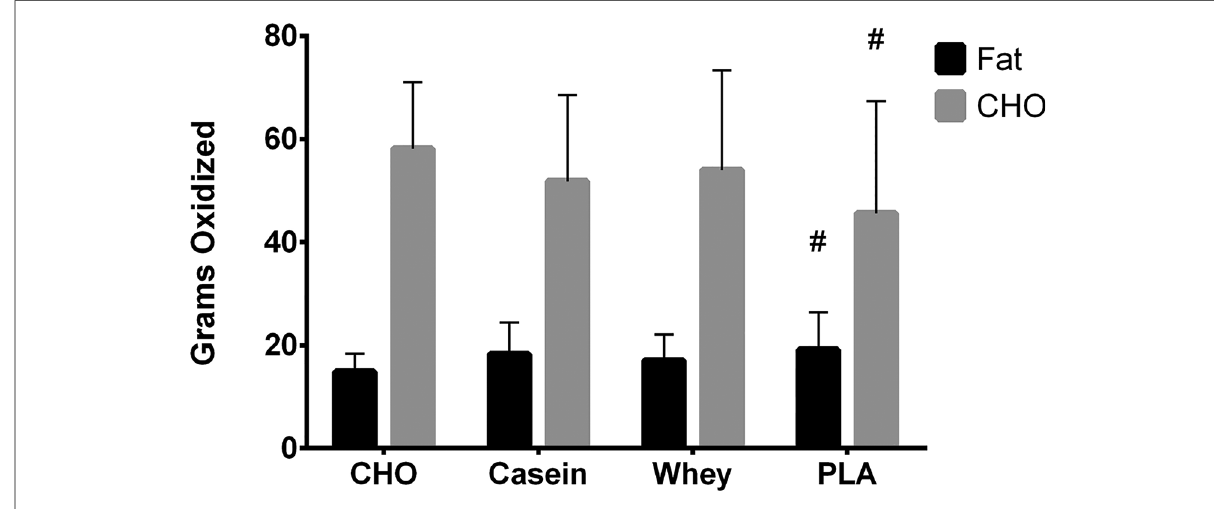
FIGURE 2 Total grams of fat and carbohydrate oxidized over the 60-min exercise bout for each condition. #, different than CHO ( p